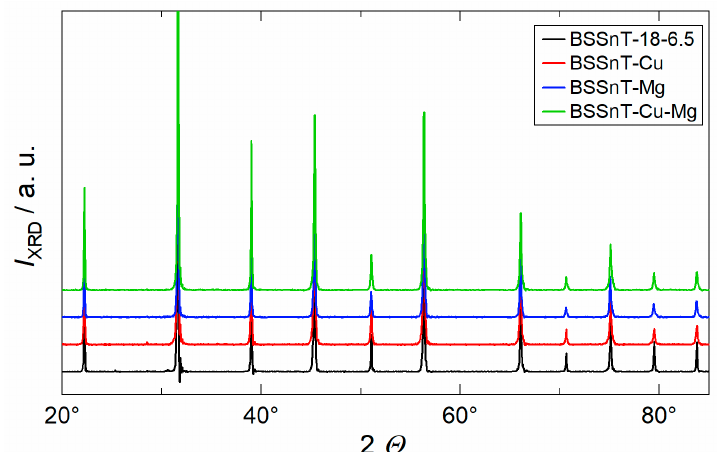
Figure 4. X-ray diffraction pattern of sintered BSSnT-18-6.5 ceramics with different additives.